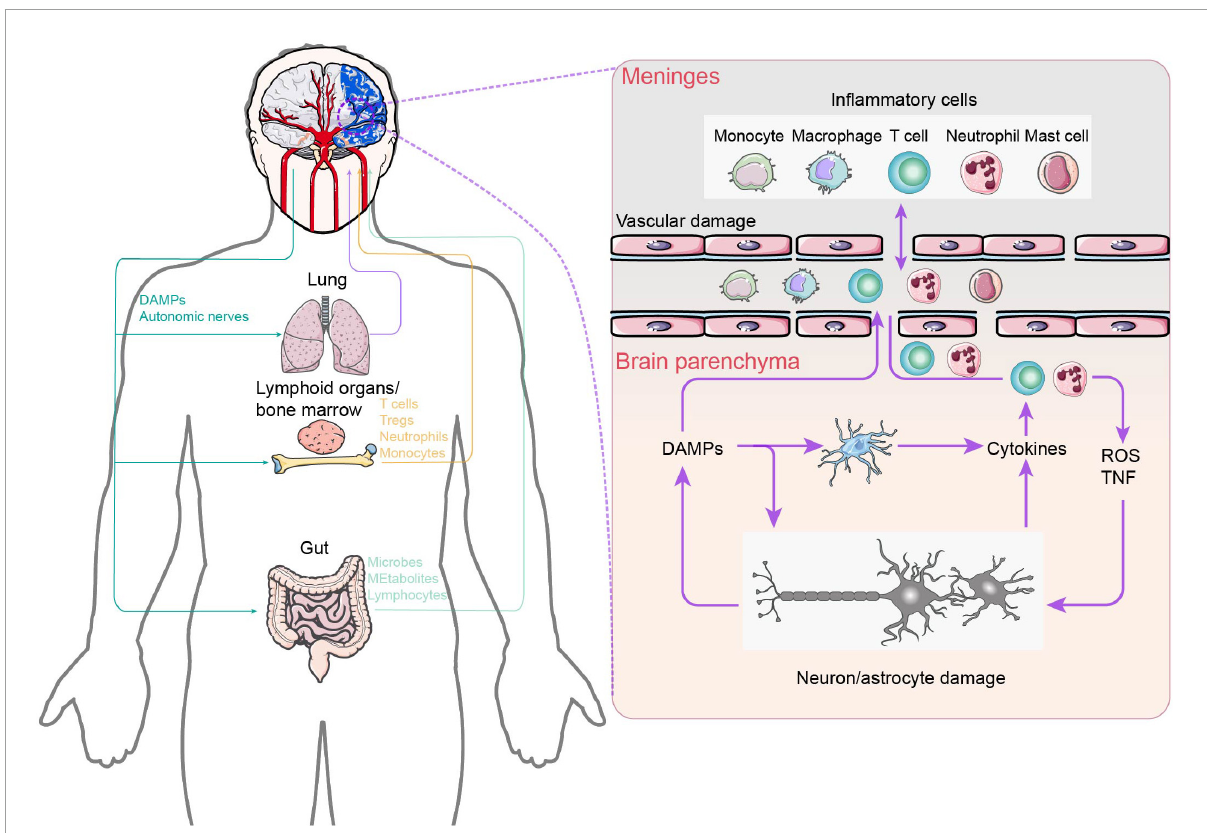
FIGURE4 Central and peripheral immune response crosstalk in stroke. After ischemia, necrotic neuronal cells appear and release DAMPs due to intracellular adenosine triphosphate depletion and hypotonic hypoxia. On the one hand, DAMPs activate innate immune receptors on brain resident immune cells, leading to the release of cytokines and chemokines, which, in turn, promote additional neutrophil entry. Neutrophils damage the brain by producing reactive oxygen species and TNF. On the other hand, brain-derived DAMPs leak into the circulation and activate systemic immunity, mobilizing innate immune cells in lymphoid organs, the lungs, and the gut. Circulating peripheral immune cells subsequently extravasate into the brain parenchyma and meninges. In addition, the increase in gut permeability triggers bacteria and their metabolites to enter into the brain parenchyma. In the left part: Purple: Lung–Brain axis. Yellow: Lymphoid organs / bone marrow–Brain axis. Purple: Gut–Brain